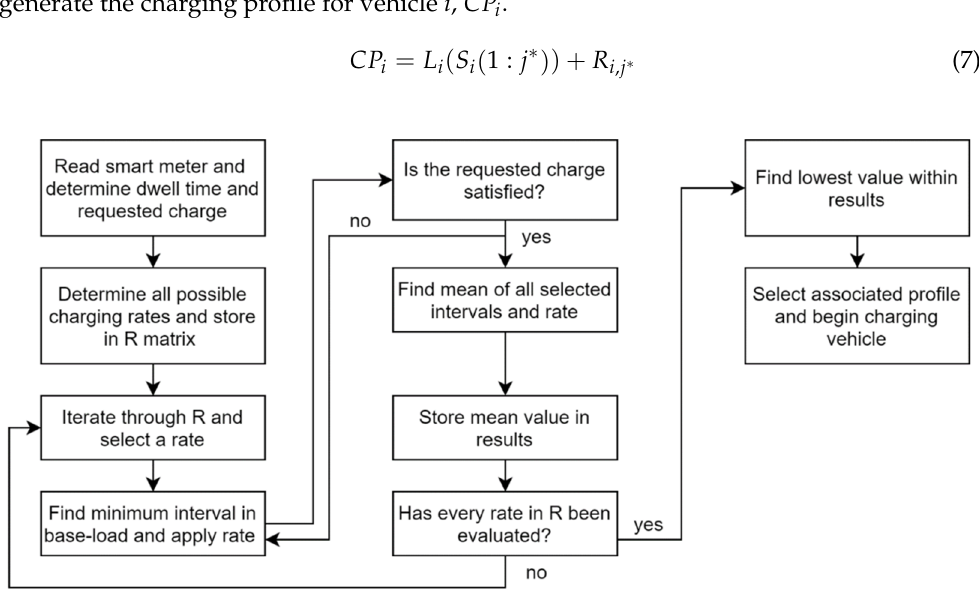
Figure 1. SRVF flow